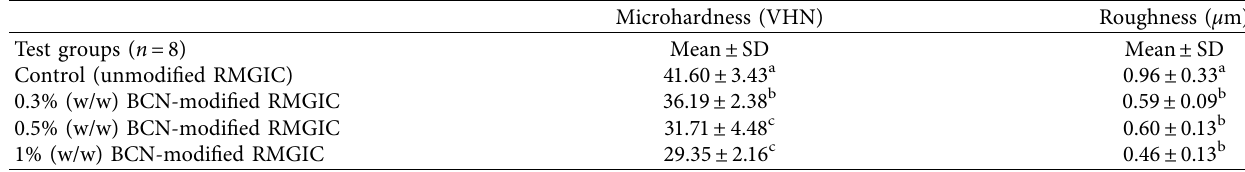
Table 1: Mean and standard deviation of microhardness and surface roughness of the studied